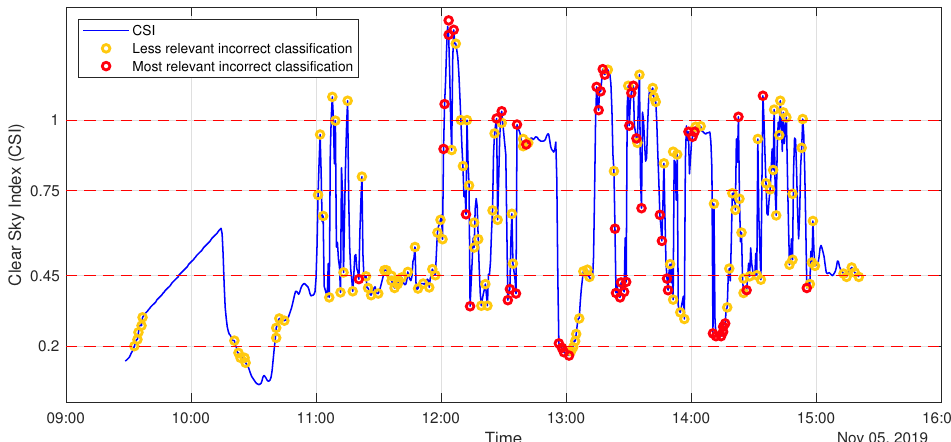
Figure 10. CSI trend with highlighted classification errors for the day of 5 November 2019.